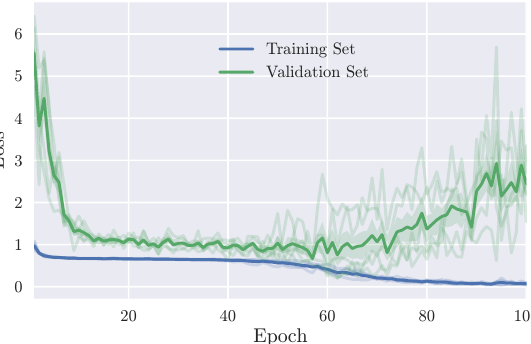
Figure 4. Training and validation loss of the pCNN model. The blue and green lines represent the average of the 5 folds for training and validation,